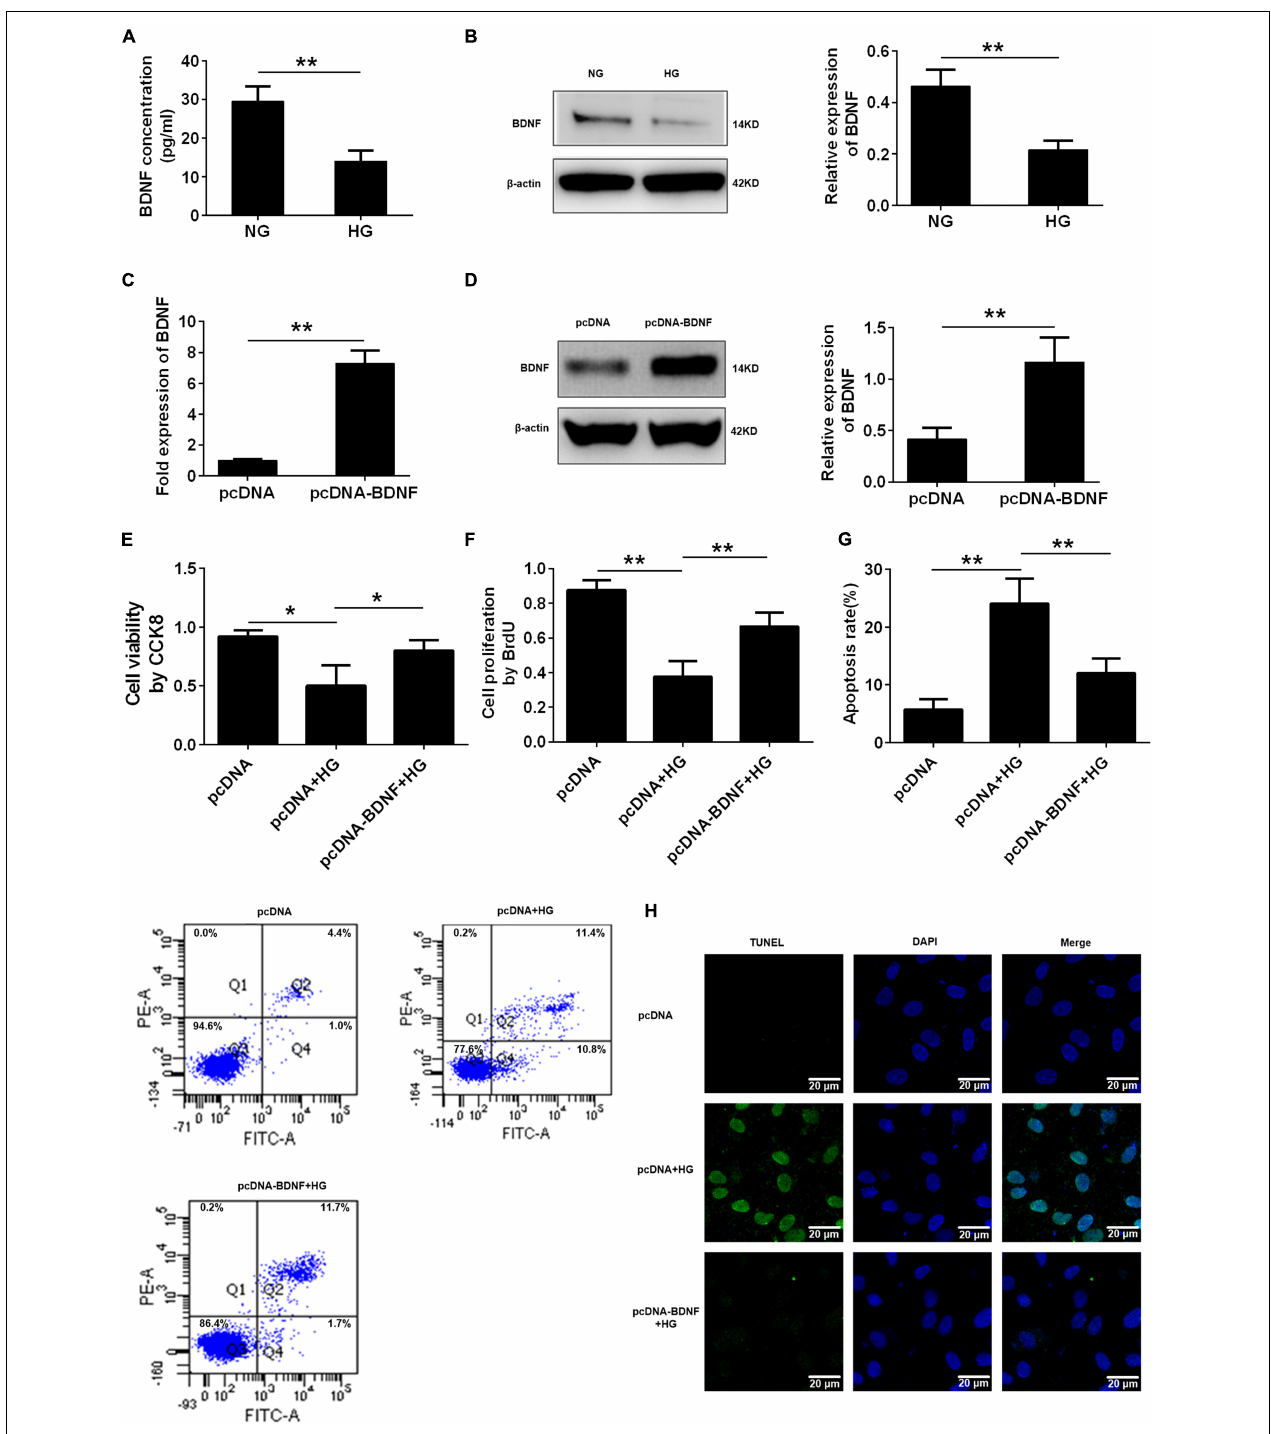
FIGURE 2 | BDNF was involved in high glucose-induced cell proliferation and apoptosis. (A) ELISA analysis of BDNF expression in HUVECs treated with NG and HG (33.3 mmol/l). (B) Western blot analysis of BDNF expression in HUVECs treated with the NG and HG conditions. The histograms represent the relative BDNF intensity. (C) q-PCR analysis of BDNF expression in HUVECs overexpressing BDNF. (D) Western blot analysis of BDNF expression in HUVECs overexpressing BDNF. The histograms represent the relative BDNF intensity. (E) CCK8 assay in HUVECs treated with pcDNA, pcDNA + HG, and pcDNA-BDNF + HG for 24 h. (F) BrdU incorporation assay in HUVECs treated with pcDNA, pcDNA + HG, and pcDNA-BDNF + HG. (G) Annexin V/PI assay in HUVECs treated with pcDNA, pcDNA + HG, and pcDNA-BDNF + HG. The histograms represent the apoptosis rates in the different groups. (H) Representative photographs of TUNEL staining in the different groups. The results are expressed as the means ± SD. ∗ p < 0.05, ∗∗ p < 0.01; two-tailed Student’s t -test and one-way ANOVA.